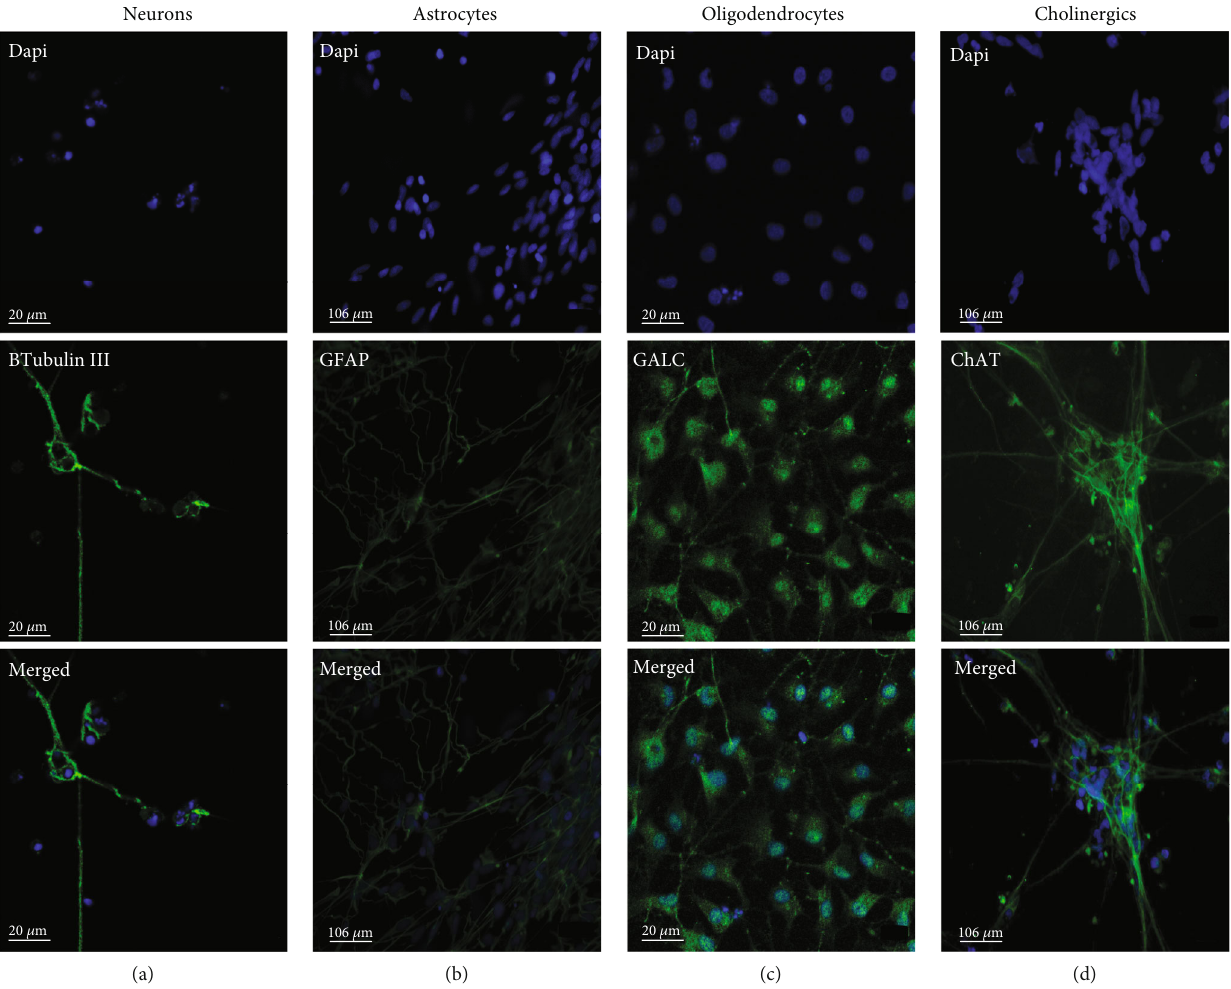
Figure 4: Fluorescence immunocytochemistry on di ff erentiated cell lineages derived from hNSCs: (a) staining of neurons with β -tubulin III antibody ( scalebar = 20 μ m ), (b) staining of astrocytes with GFAP antibody ( scalebar = 106 μ m ), (c) staining of oligodendrocytes with GALC antibody ( scale bar = 20 μ m ), and (d) staining of cholinergic neurons with ChAT antibody ( scale bar = 106 μ m ). Nuclei stained with DAPI are shown in blue and targets in